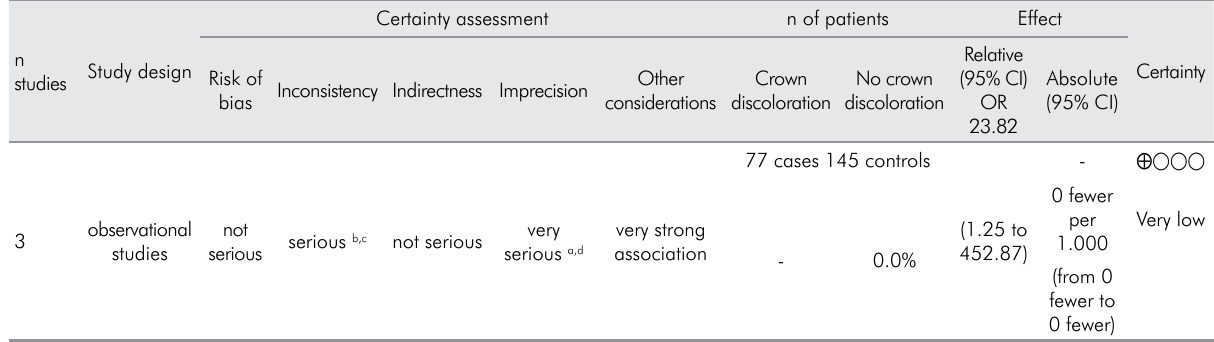
Table 5. Evidence profile. Association of crown discoloration and pulp necrosis in traumatized permanent teeth.